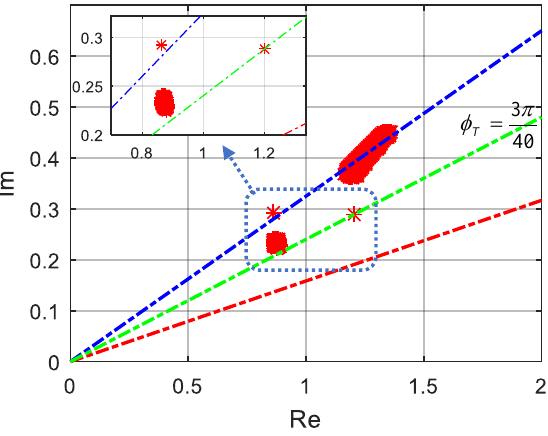
Figure 6. Minimum angle root placement in the Riemann sheet for the FOPID control system.